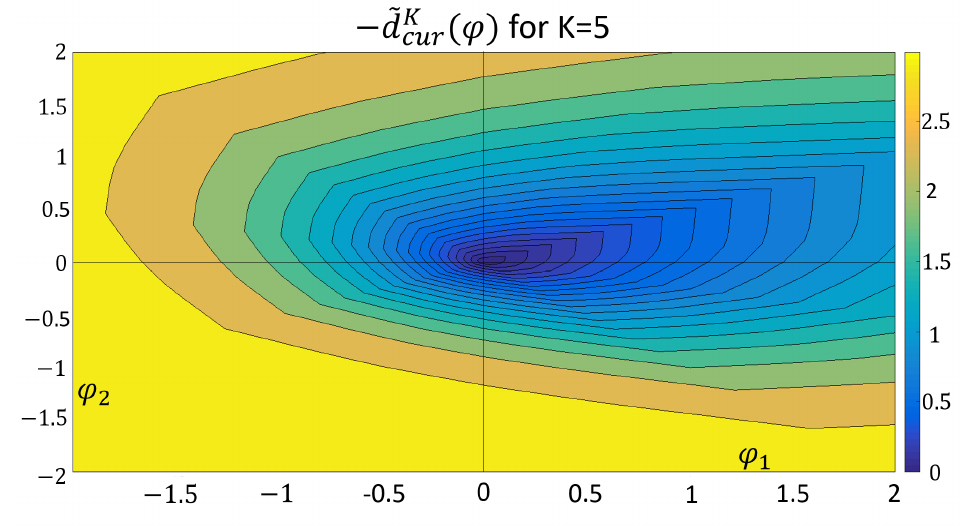
Figure 6. Contour levels for r ( K )